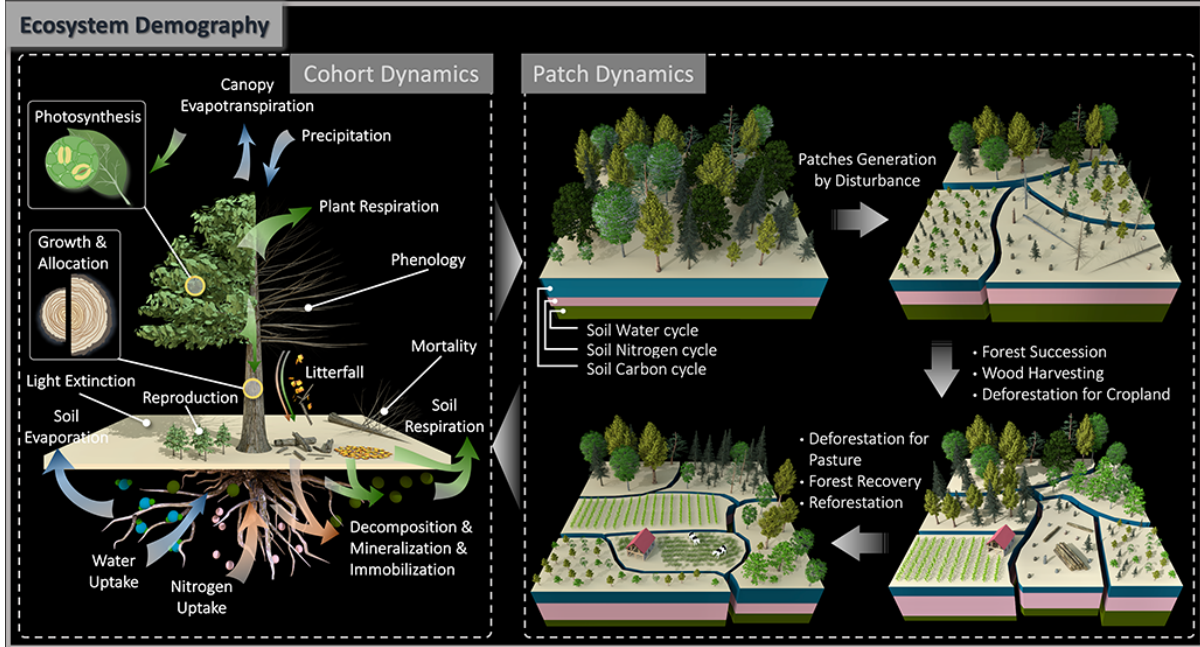
Figure 2. Schematic diagram of processes represented in the ED model. Dynamics at cohort level consist of carbon-related flow (green arrows), water-related flow (blue arrows) and nitrogen-related flow (orange arrows). Carbon dynamics include carbon assimilation by pho- tosynthesis, carbon allocation for plant growth in height/DBH, reproduction and respiration, carbon translocation between plants and soil through tissue turnover as litterfall and dead plants due to mortality, and carbon decomposition and respiration in soil carbon pools. Water dynamics include water inputs from precipitation and infiltration into soil, uptake by vegetation, and evaporation and transpiration from the soil and canopy. Nitrogen dynamics include nitrogen uptake from soil pools, translocation from vegetation to soil through litterfall and dead plants, and mineralization and immobilization in soil. Note that not all processes that ED characterizes are depicted here. Dynamics at the patch level consist of consequences of a variety of disturbance events, both natural and anthropogenic. Patch dynamics include disturbance- driven patch heterogenization in age and areas, forest succession, wood harvesting, deforestation for cropland and pasture expansion, and forest recovery and reforestation from abandoned cropland, harvested forest and